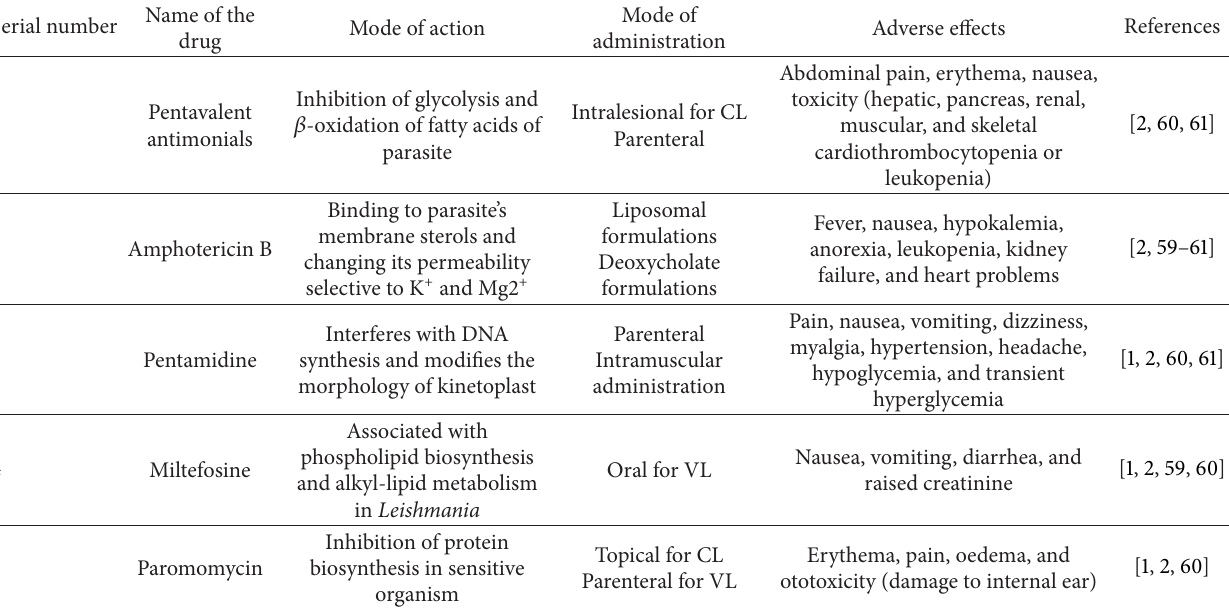
Table 1: Drugs used for the treatment of